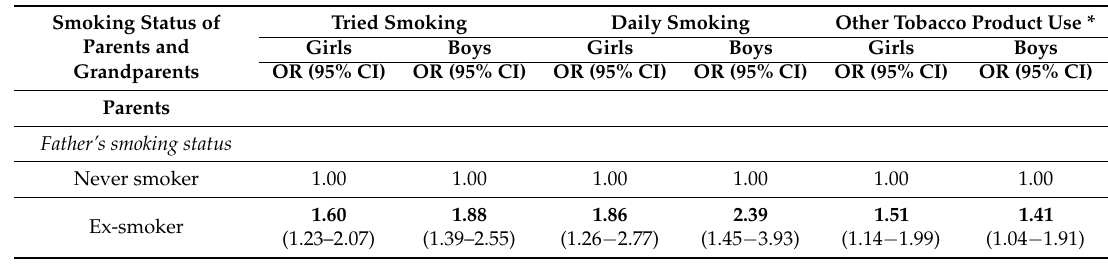
Table A2. ORs and 95% CIs for boys’ and girls’ smoking experimentation, daily smoking and other tobacco product use * by parents’ smoking statuses, adjusted for age, parents’ education and employment